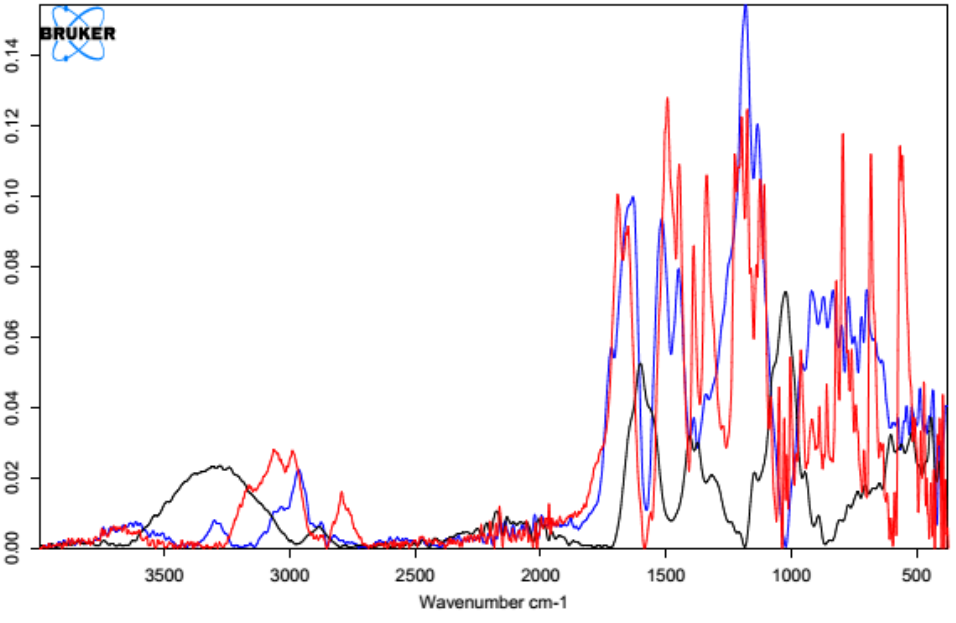
Figure 20. Schematic reaction of the polysaccharide–peptide condensation by using DMT/NMM/TsO - as the coupling reagent .